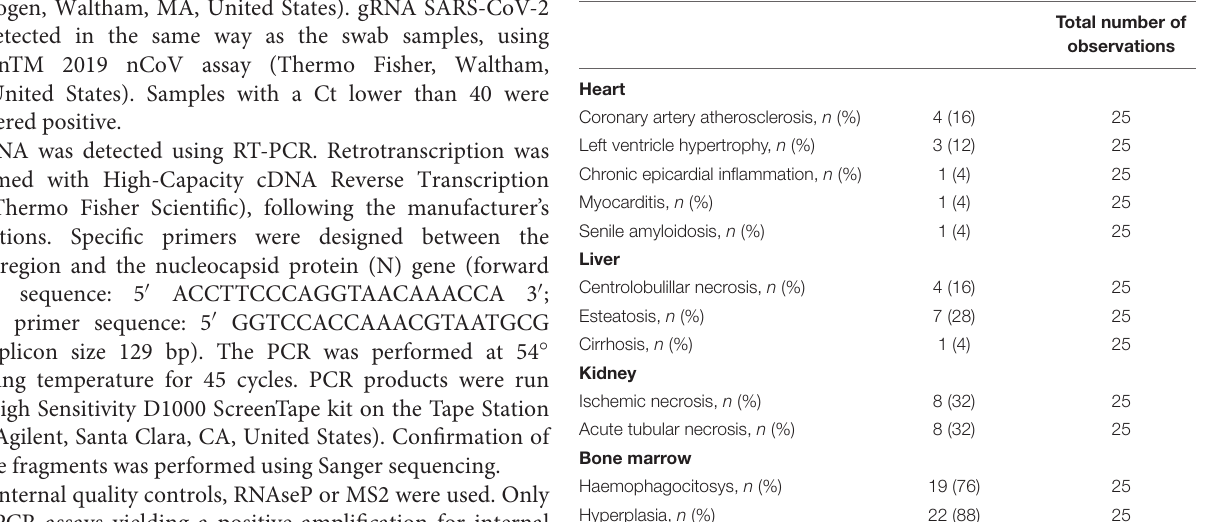
TABLE 4 | Main pathological findings in other